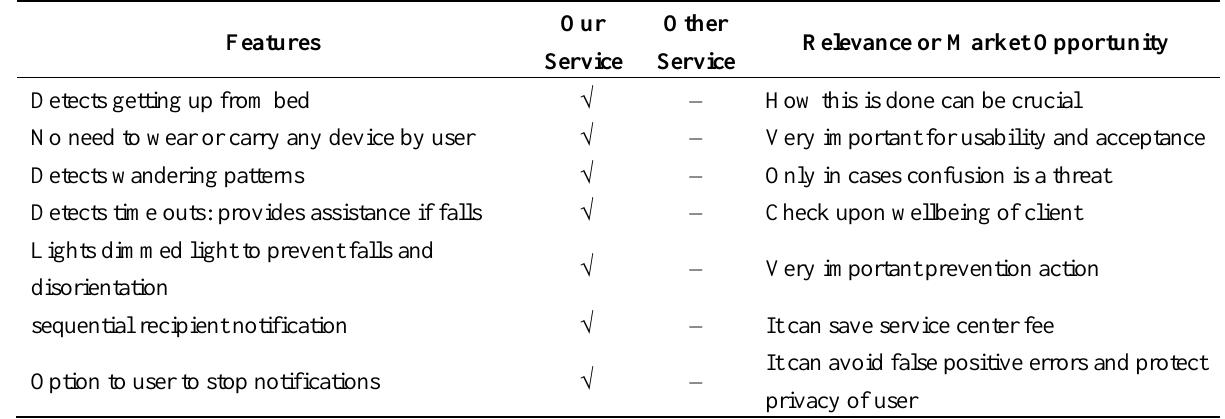
Table 12. Added value and